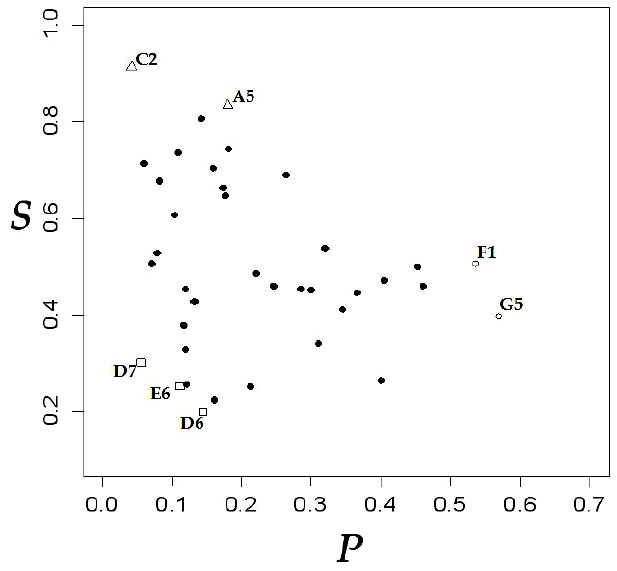
Fig. 2 . Ecosystem service trade-offs as predicted by realized smallholder land-use